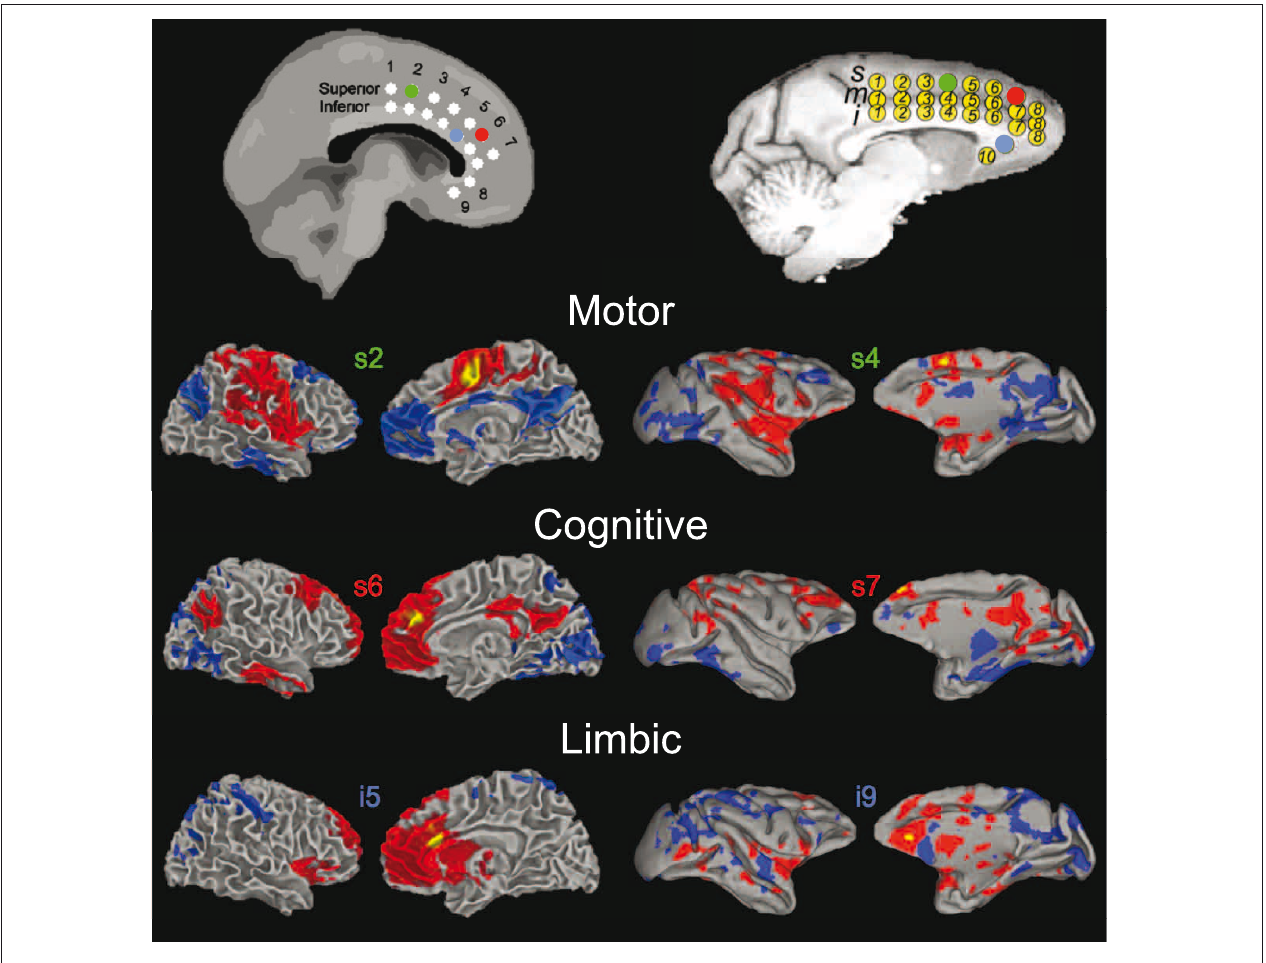
FIGURE 5 | Homologous functional subdivisions of the anterior cingulate cortex. Functional connectivity profiles of seed regions within the anterior cingulate cortex are shown for the human (left column) and macaque (right column). Color-coded seed locations are shown are